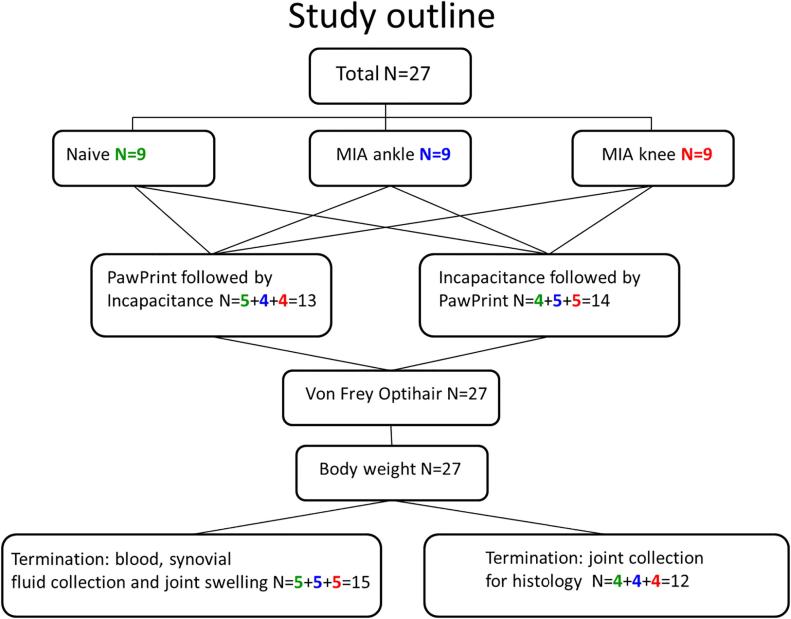
The study outline.